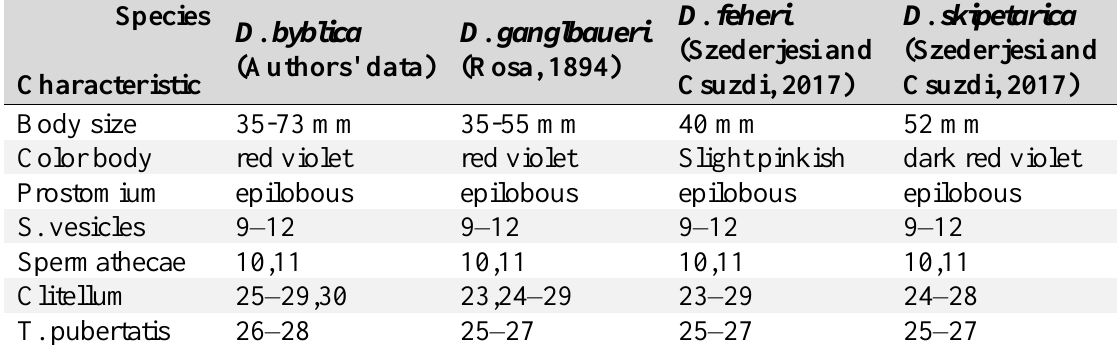
Table 3. Distinguishing taxonomic characteristics of species of group Dendrobaena byblica in the Balkans and the neighbouring